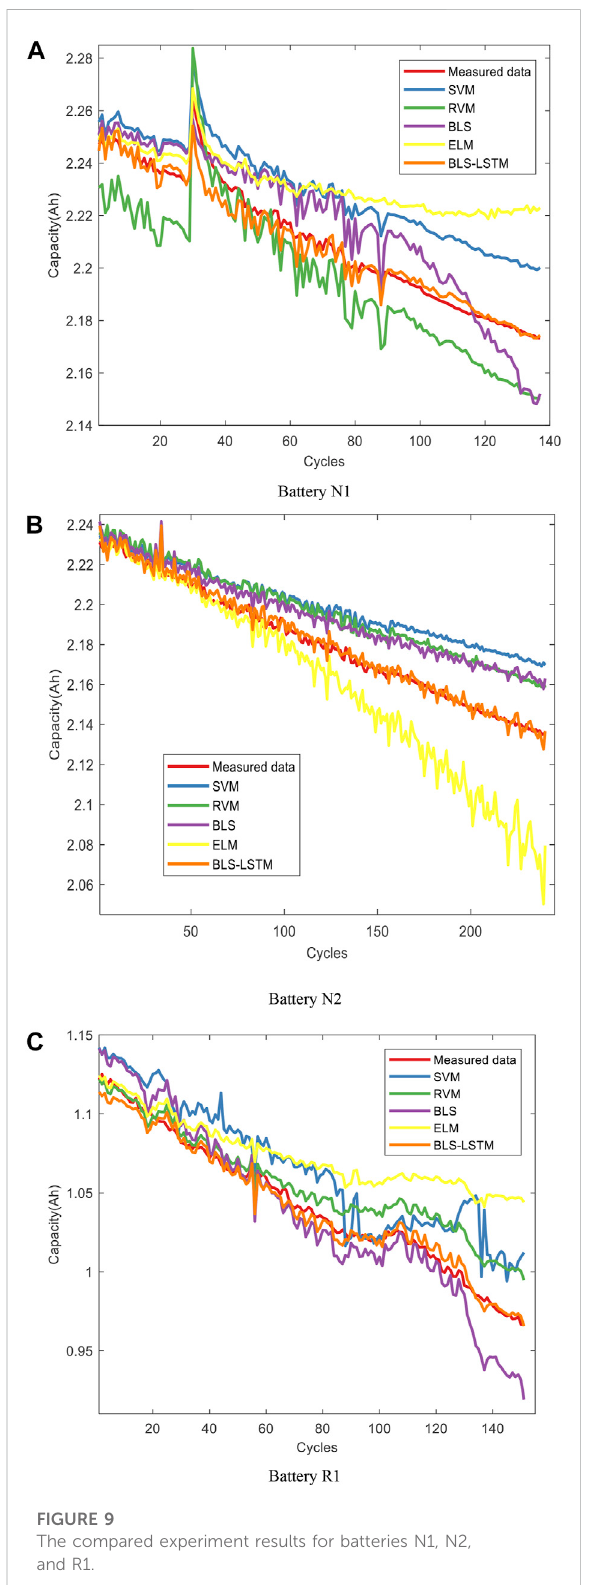
FIGURE 9 The compared experiment results for batteries N1, N2, and